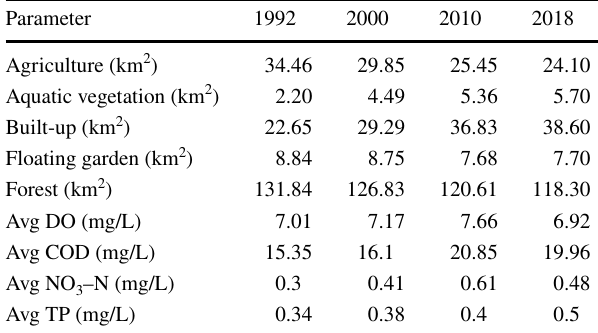
Table 3 LULC and WQ parameters at different points of time Parameter